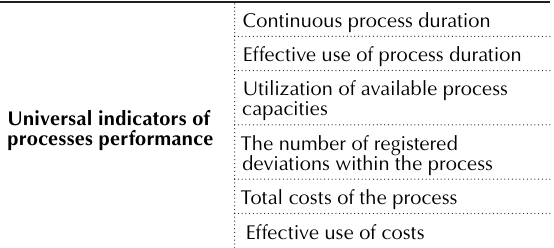
Table 4. Indicators of measuring performance of non-production